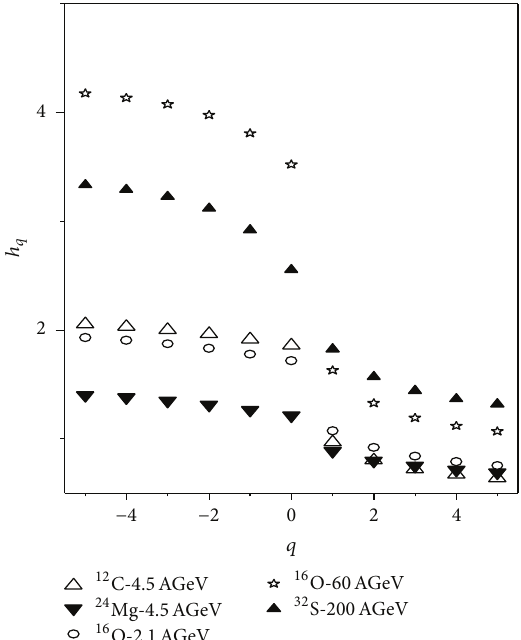
Figure 4: Comparison of ordinary Hurst exponent for experimental and shuffled data for 32 S-AgBr interactions at 200 AGeV.